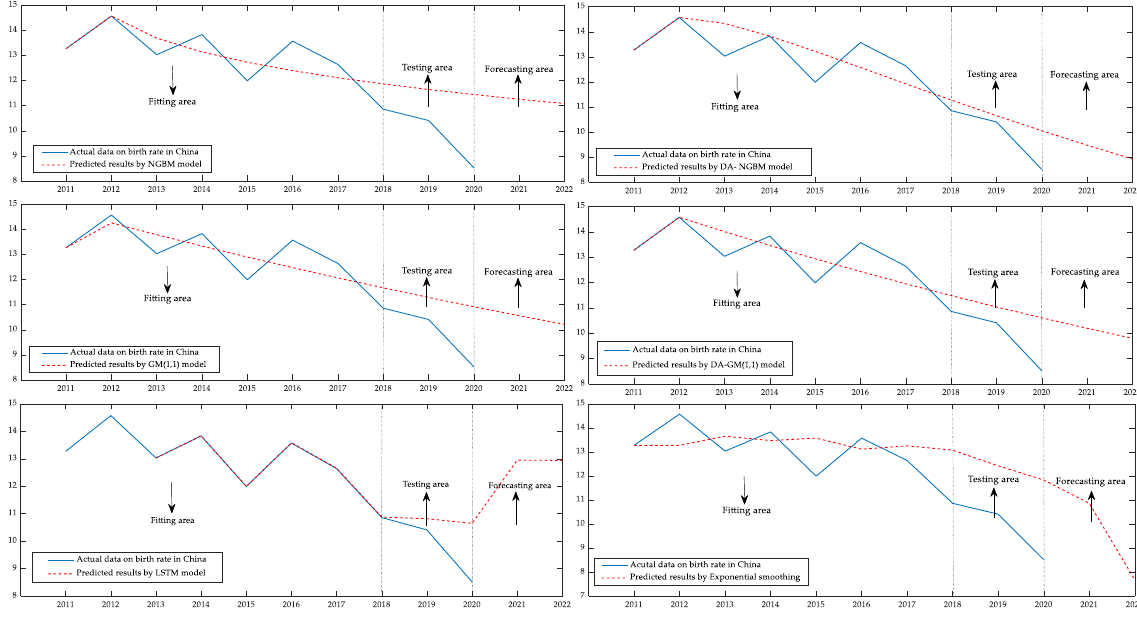
Figure 3. Comparison of the fitting and forecast curves of China’s birth rate from 2011 to